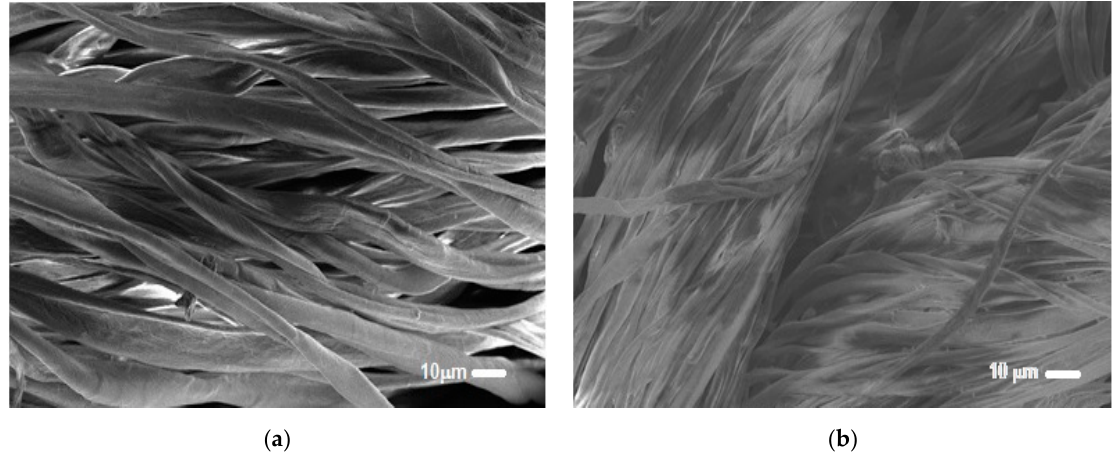
Figure 5. SEM micrographs of ( a ) untreated cellulosic sample and ( b ) PEM grafted bio-sorbent material.